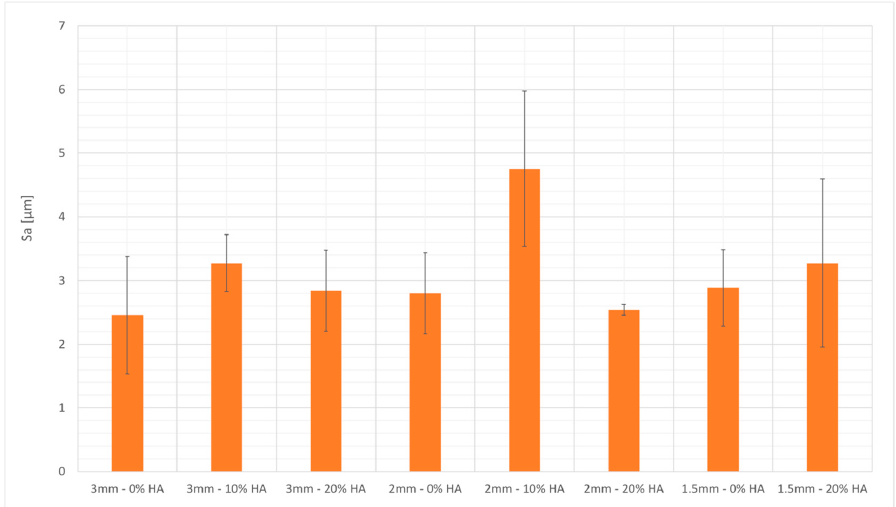
Figure 7. Surface roughness measurements of the beads built by vat photopolymerization.